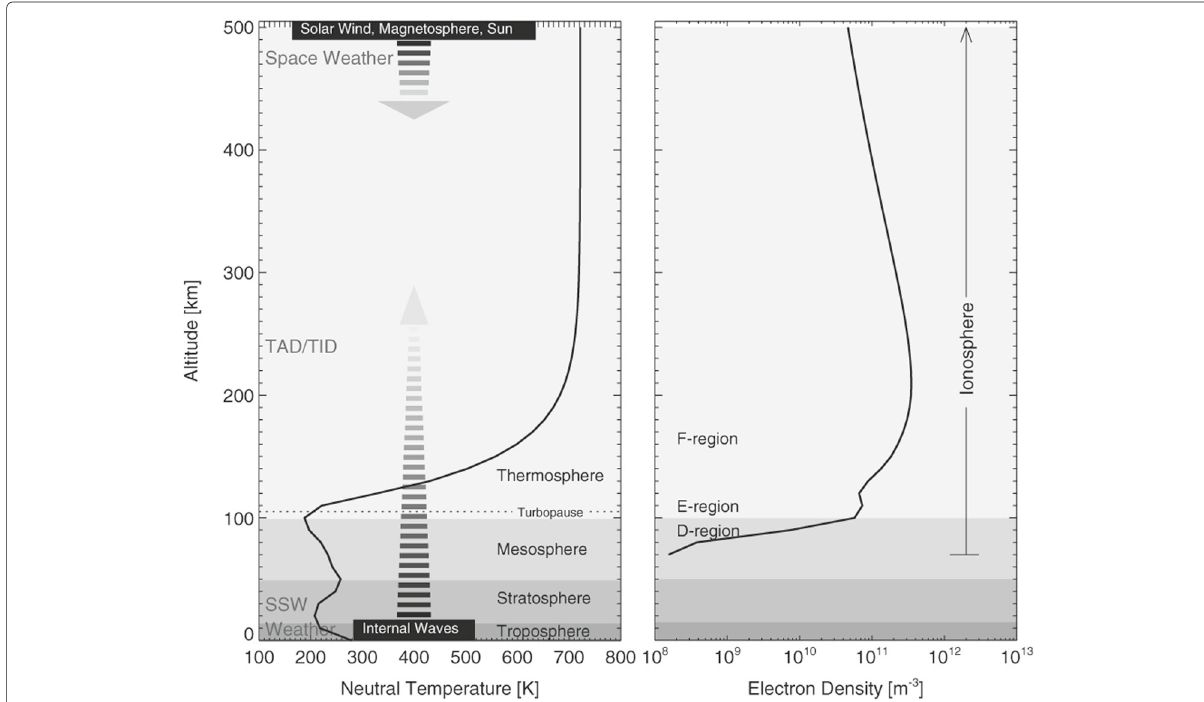
Fig. 10 Vertical coupling in the atmosphere-ionosphere system, from the troposphere to the thermosphere-ionosphere. The atmosphere is influenced from below by internal waves (gravity waves, tides, planetary waves, Kelvin waves) and from above by solar and geomagnetic processes, referred to as space weather processes. These mechanisms produced wave-like disturbances in the upper atmosphere, known as traveling ionosphere/atmospheric disturbances (TIDs/TADs). The thermosphere and ionosphere coexist, interacting with each other in a two-way coupled manner. Taken from Yi˘git and Medvedev